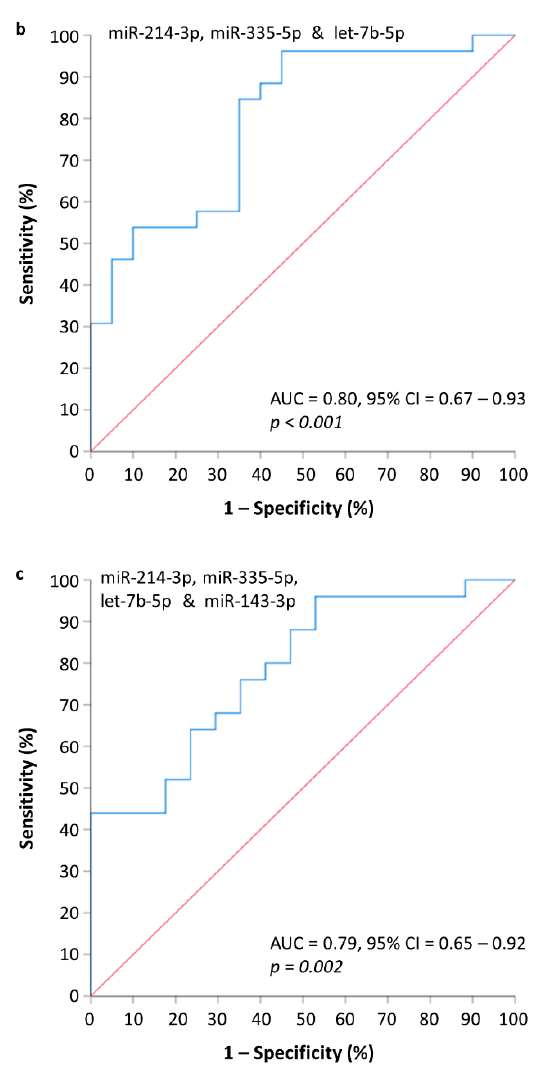
Figure 3. Receiver operating characteristic (ROC) curves for combinatorial models of ( a ) miR-214-3p and miR-335-5p; ( b ) miR-214-3p, miR-335-5p and let-7b-5p; ( c ) miR-214-3p, miR-335-5p, let-7b-5p, and miR-143-3p. The combination of miR-214-3p, miR-335-5p, and let-7b-5p into a standalone model constitutes the most prominent predictor of MMBD in MM patients.